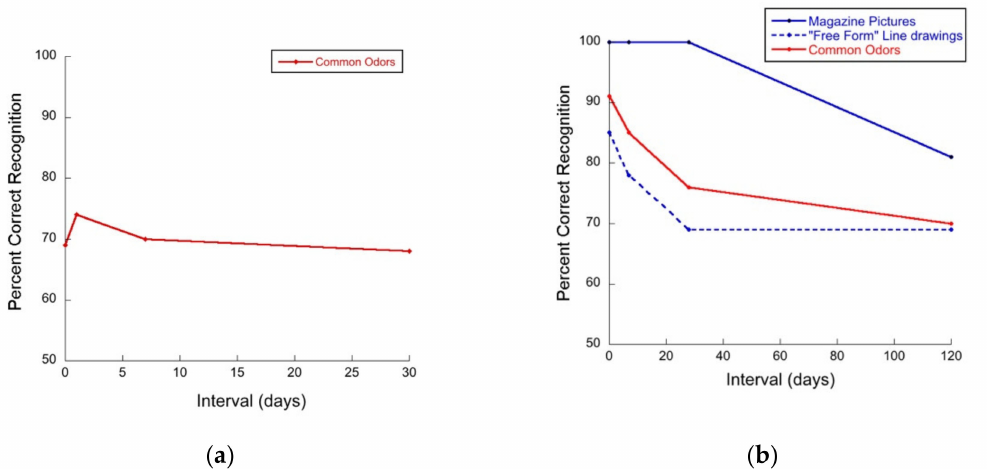
Figure 1. ( a ) Flat forgetting curve for common odors over 30 days, adapted from Engen and Ross [16]. ( b ) Initial decay of visual and odor recognition memory followed by flat forgetting curves for common odors and free form line drawings over time, adapted from Lawless